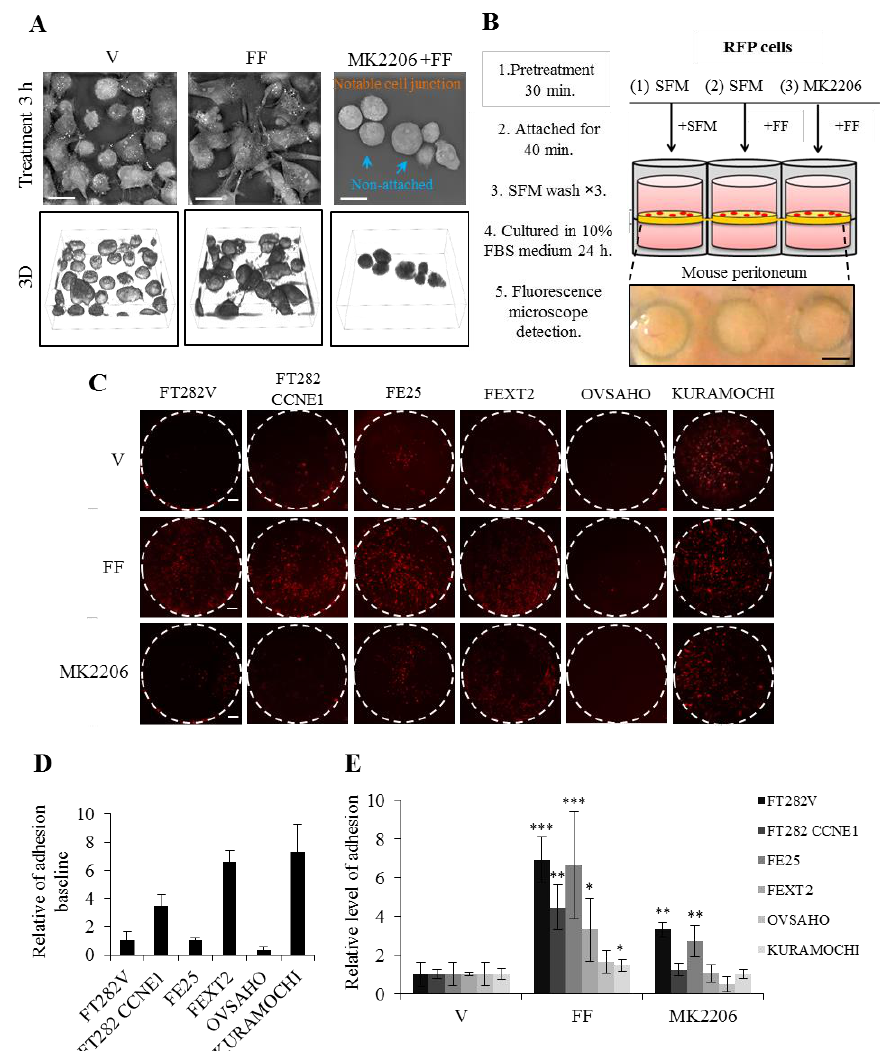
Figure 5. FF increases attachment growth of FTE cells on the peritoneum, partially dependent on AKT. ( A ) Label-free 3D refractive index image (Nanolive SA, Tolochenaz, Switzerland) of FE25 cells cultured in serum free, with or without 3h-FF treatment and AKT inhibition. ( B ) Schematic diagram of the ex vivo assay of attachment growth on peritoneum tissue as described in Materials and Methods. Scale bar, 1000 µm. ( C ) Representative image of adhesive growth of RFP-labelled cells on the mouse peritoneum with the same pretreatments. Scale bar, 200 μm. ( D ) Comparison of baseline peritoneal adhesion of different cells. By using Image J, adhered RFP+ cells were counted and compared using the value of FT282-V as a reference. ( E ) Changes of adhesion value after FF treatment with or without AKT inhibition (MK2206). The treat and no treat comparisons were done on the same peritoneum. Three or more independent experiments were done to get the mean value. Error bar represents mean ± SD, the asterisk represents comparison of vehicle treatment. * p < 0.05, ** p < 0.01, *** p < 0.001 by two-sided, unpaired Student’s t -test.